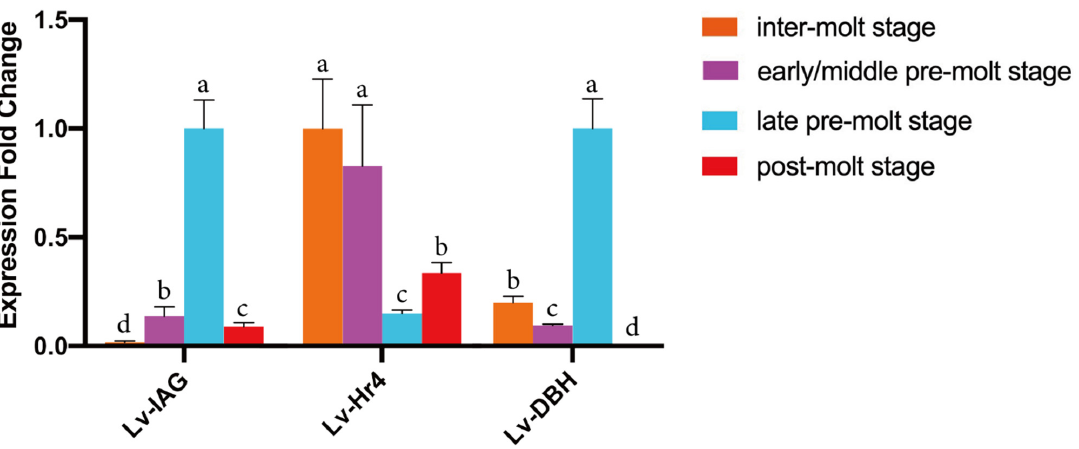
Figure 2. Expression profiles of Lv-IAG , Lv-Hr4, and three Lv-DBH genes in AG at different molting stages. Data are represented as means and standard deviations. Statistical differences were determined using Student’s t -test. The different letters indicate significant differences in gene expression level at the same molt stage (n = 3).